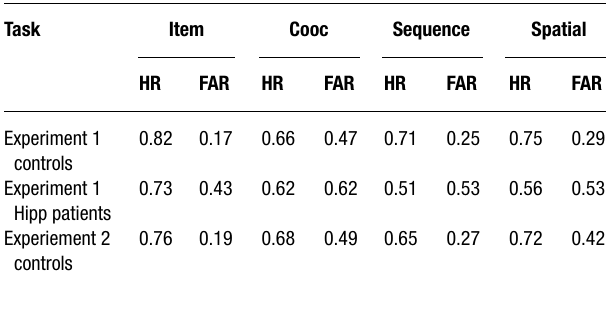
Table 4 | Hit and false alarm rates for control participants on each task in Experiments 1 and 2 as well as the hippocampal patients from Experiment